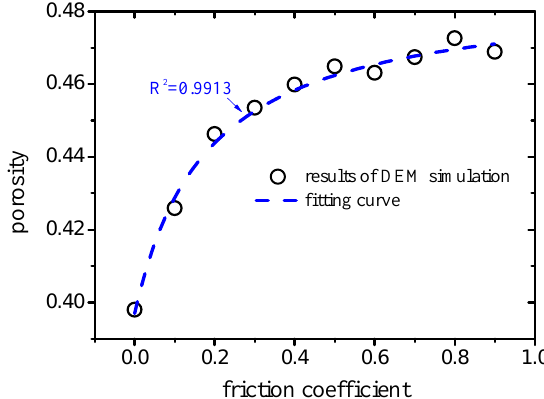
Figure 5. Relation between friction coefficient and porosity of mono-sized